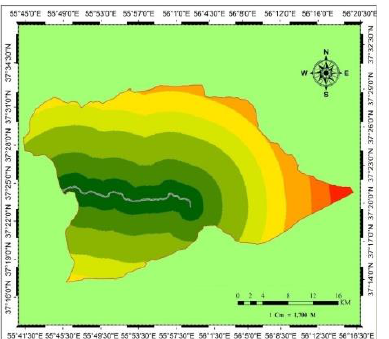
Table 2. Categorization of Vegetation Type